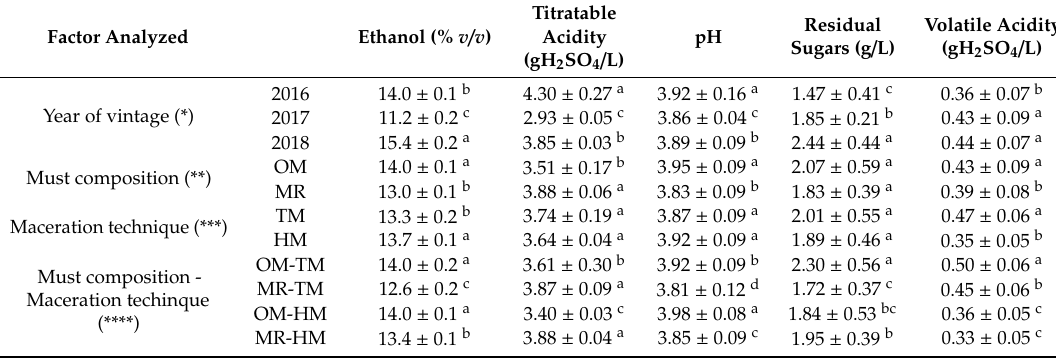
Table 1. General composition of the